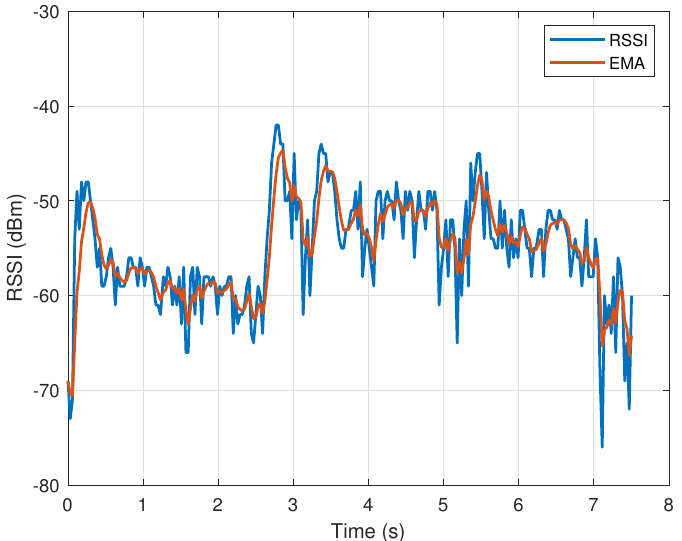
Figure 7. RSSI signal measurements associated with putting a book on a shelf. Blue line—RSSI measurements, red line—exponential moving average of